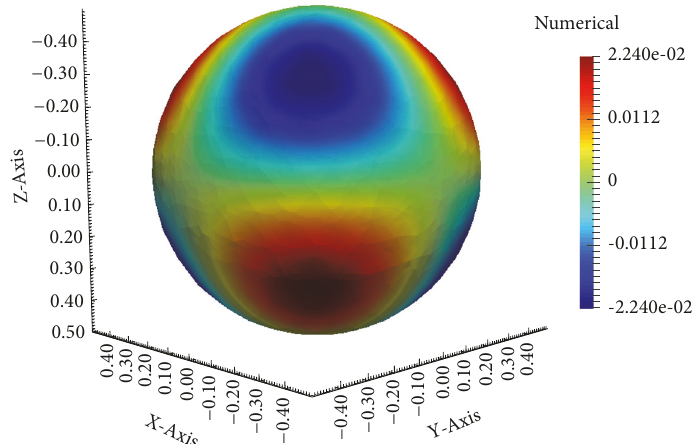
Figure 16: The numerical solutions 𝑢(𝑥,𝑦, 0) with 𝑇 = 3 , 𝜏 = 0.2